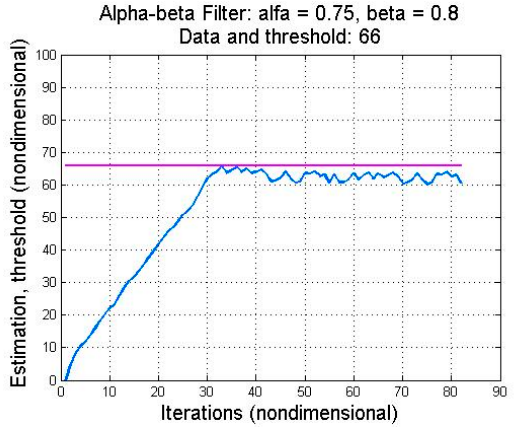
Figure 10. The estimated value of the α – β – γ – δ filter exceeds the threshold at iteration 33.